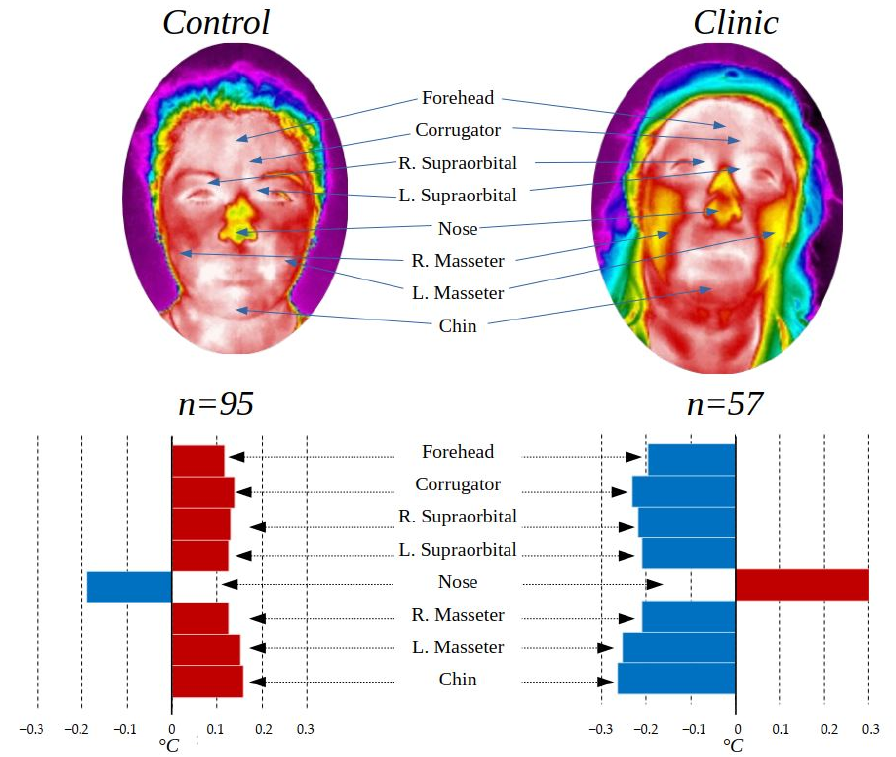
Figure 9. Control group and clinic group comparison.